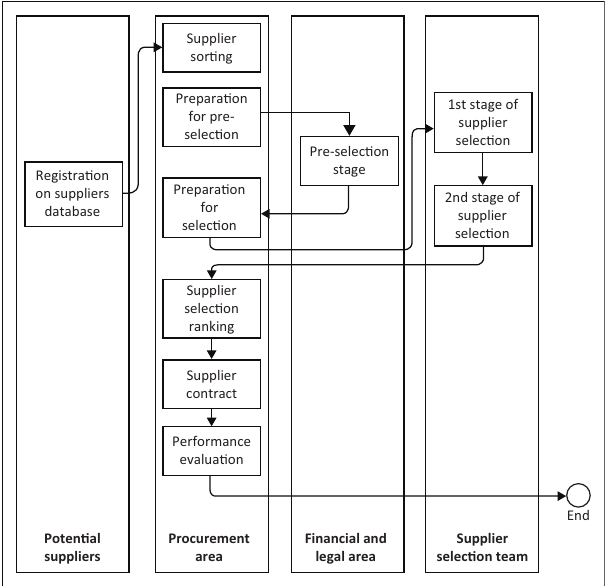
FIGURE 1: Group decision-making supplier selection